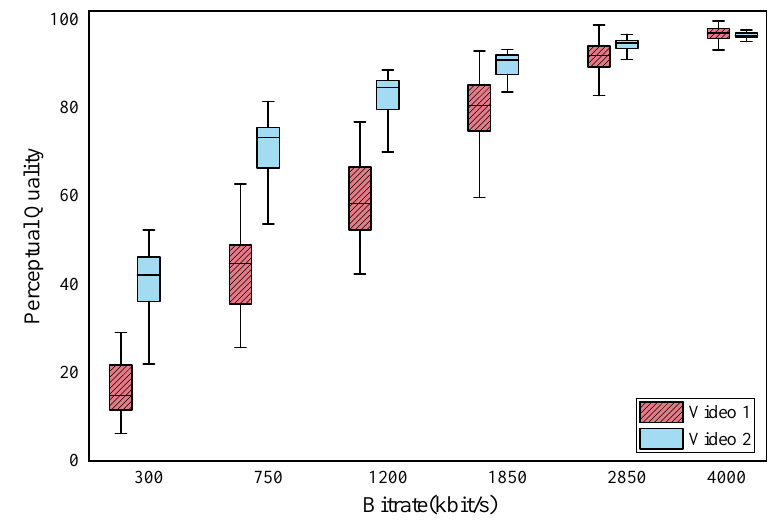
Figure 1. The perceived quality of different videos at each